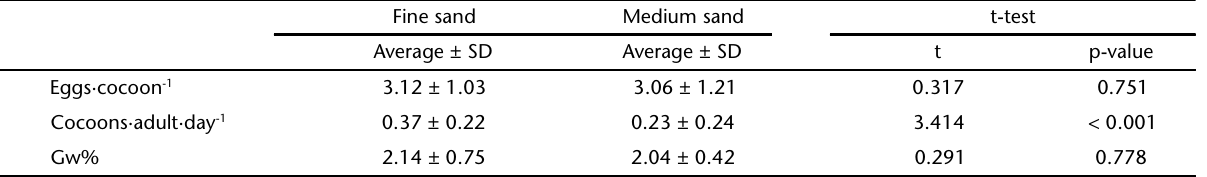
Table II. Average number of eggs per cocoon (± standard deviation [SD]) and of cocoons per adult per day (± SD), and average rate of daily growth (Gw%) (± SD), observed for Limnodrilus hoffmeisteri cultivated in fine sand (0.057-0.250 mm) and medium sand (0.250- 1.000 mm) at 25 ± 1°C during 175